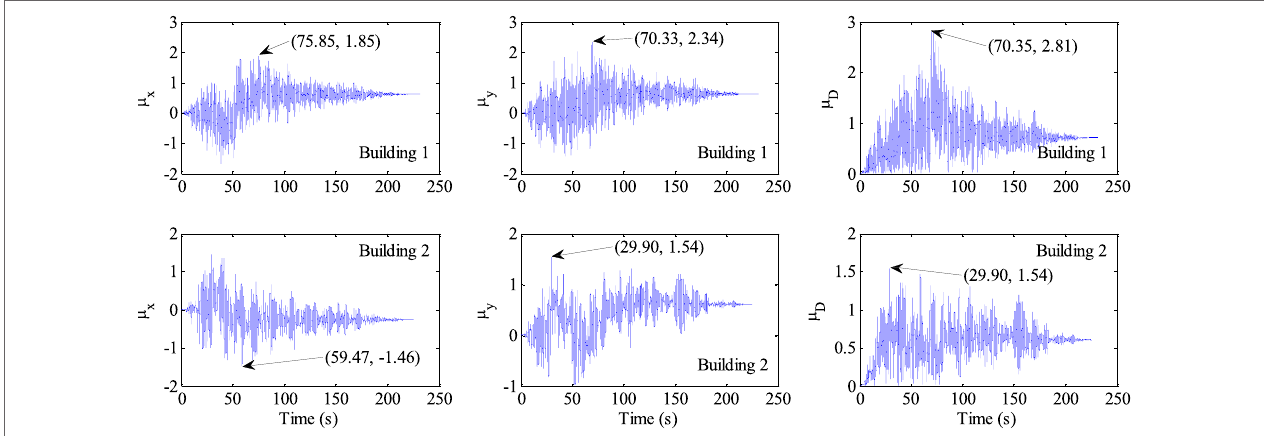
FIGURE 5 | Nonlinear inelastic response of the buildings modeled as 2-degree-of-freedom systems, in terms of normalized displacement response μ x , μ y , and μ D , under the bidirectional ground motions shown in Figure 4 . The peak normalized displacement and its corresponding time is also shown.